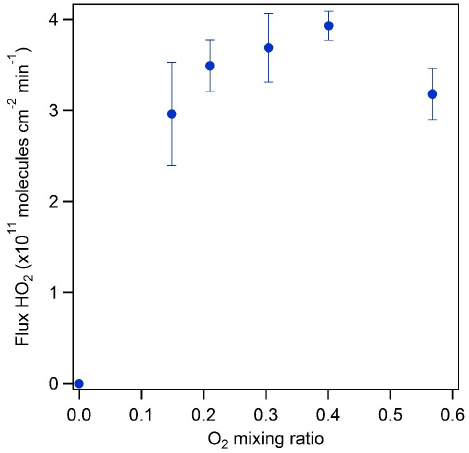
Figure 5. The indirect flux of HO 2 in moleculescm − 2 min − 1 , mea- sured by NO loss and normalized to the film surface area as a func- tion of relative humidity.